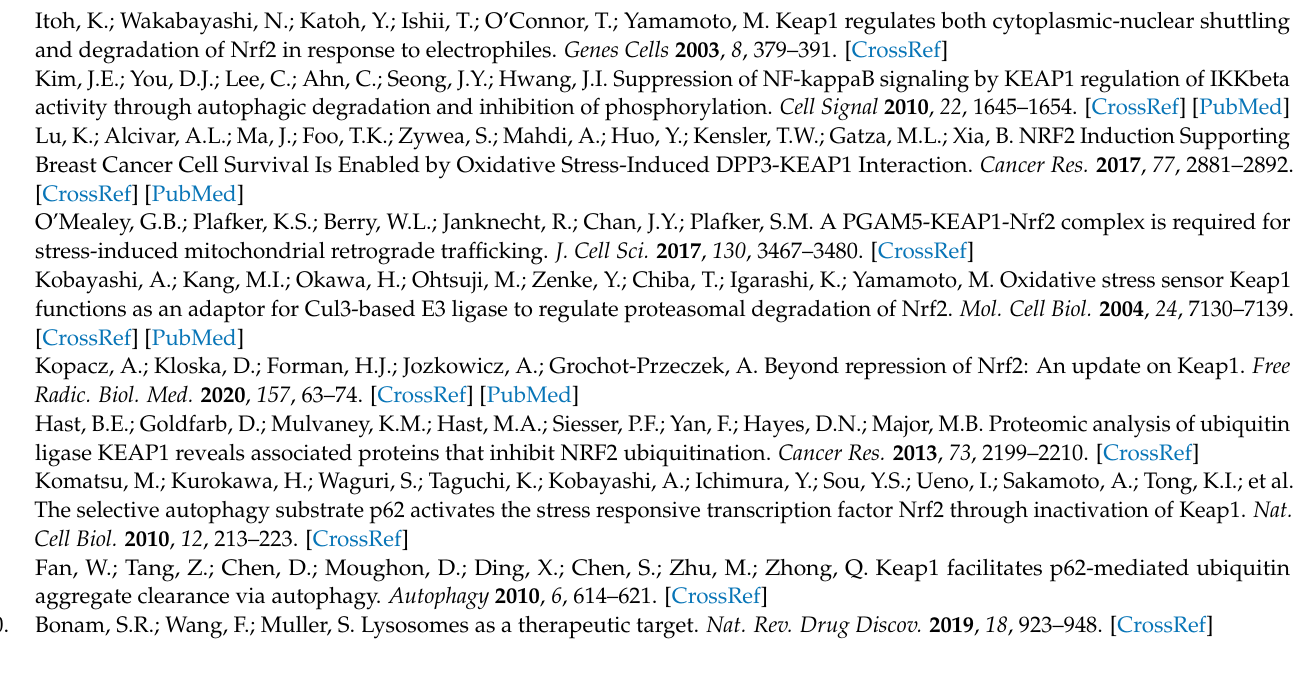
Figure S2: KEAP1 deficiency induces ubiquitinated protein